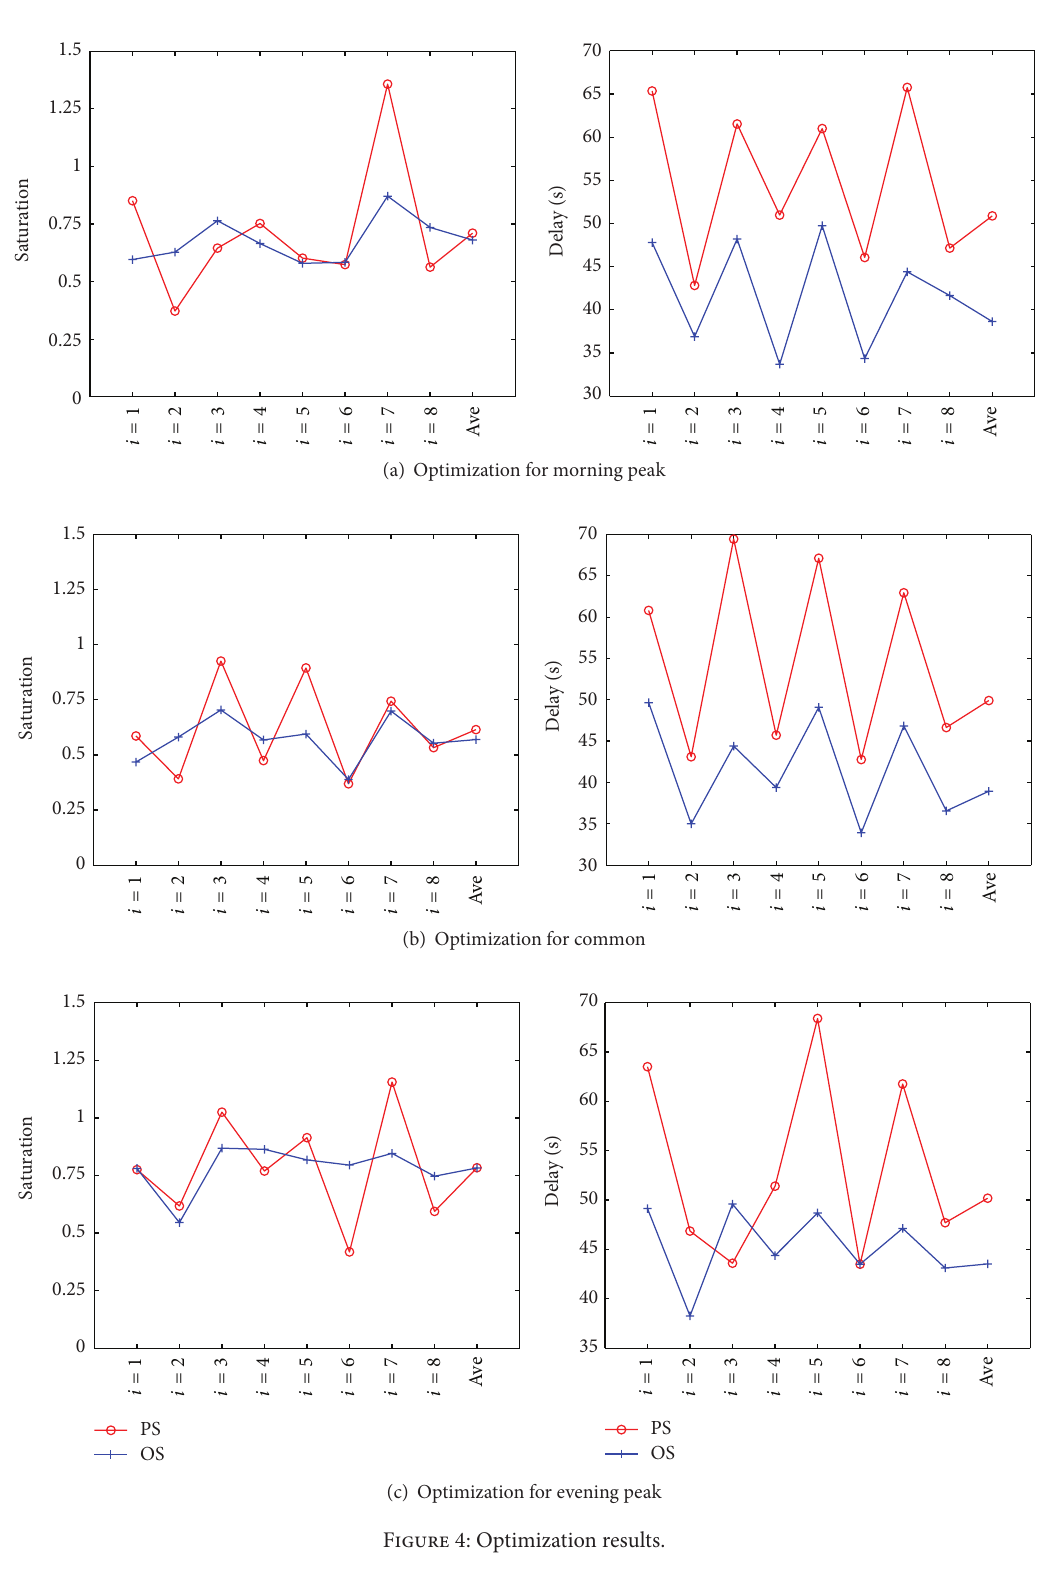
Figure 4: Optimization